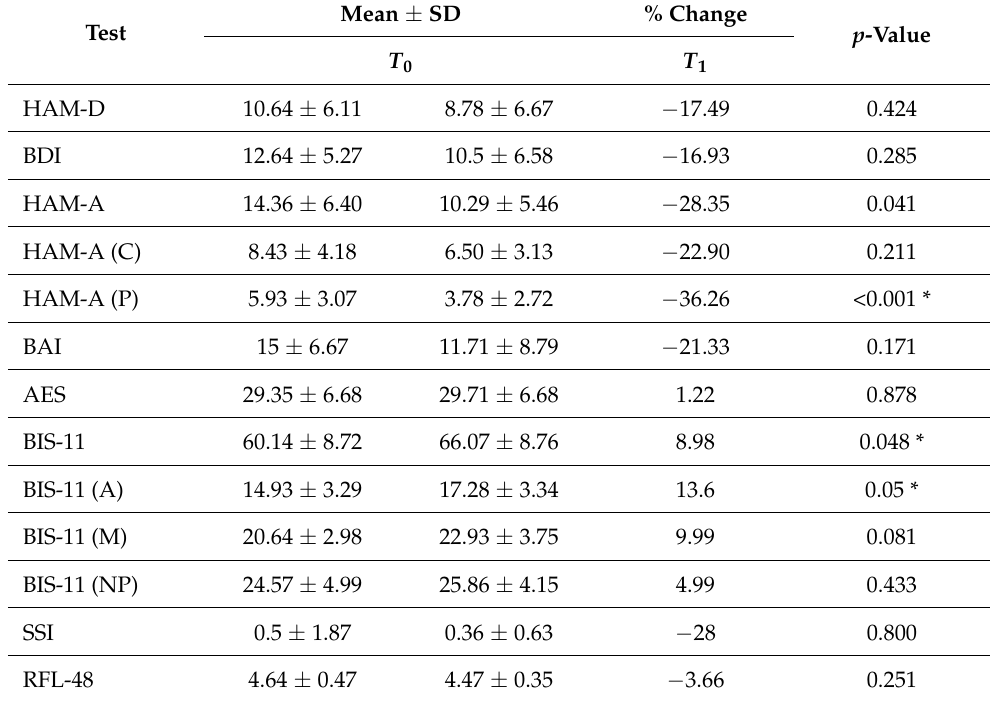
Table 2. Results of the psychiatric rating scales.